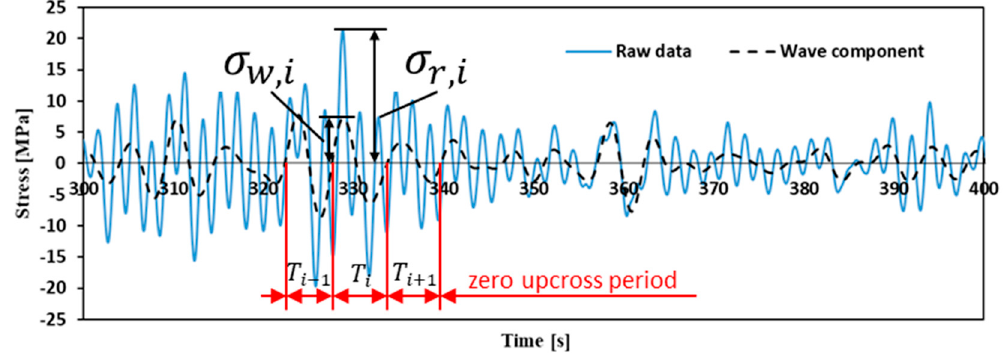
Figure 4. Time-series stress data of the vertical bending component after filtering.